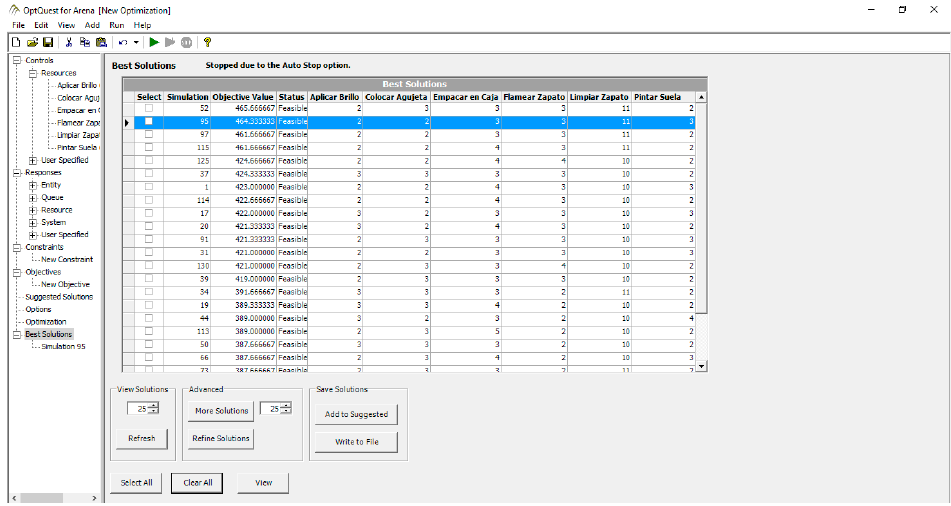
Figure A8 . Optimization, considering the target value, current value and best value.